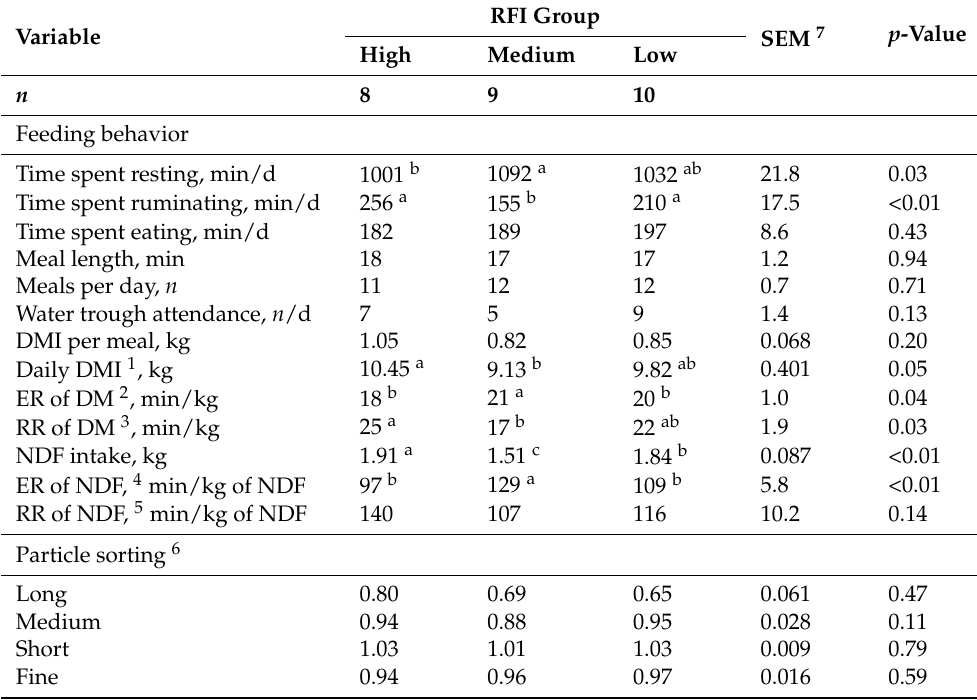
Table 3. Feeding behavior and particle sorting of Nellore yearling bulls consuming high-concentrate diets classified by residual feed intake